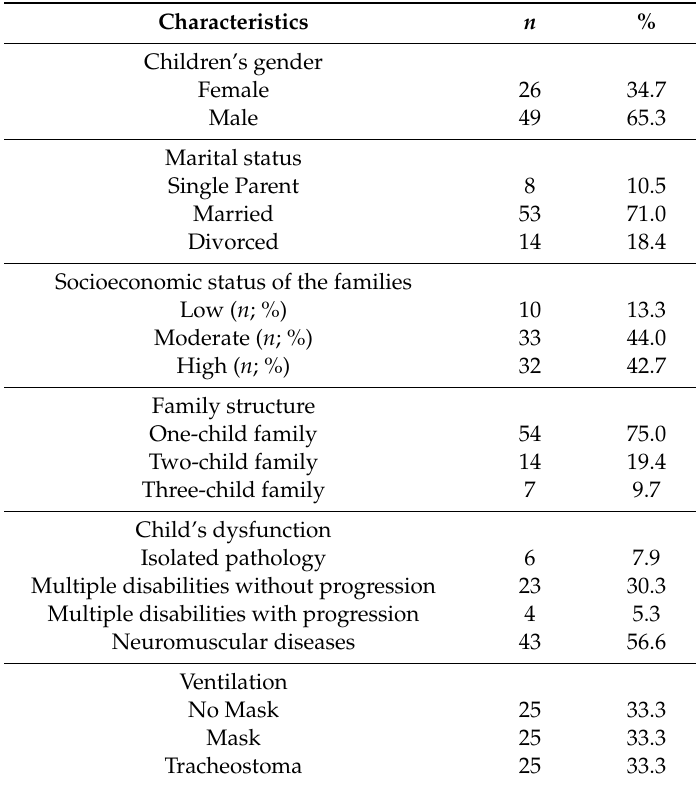
Table 1. Demographic data of study sample ( n = 75 families).